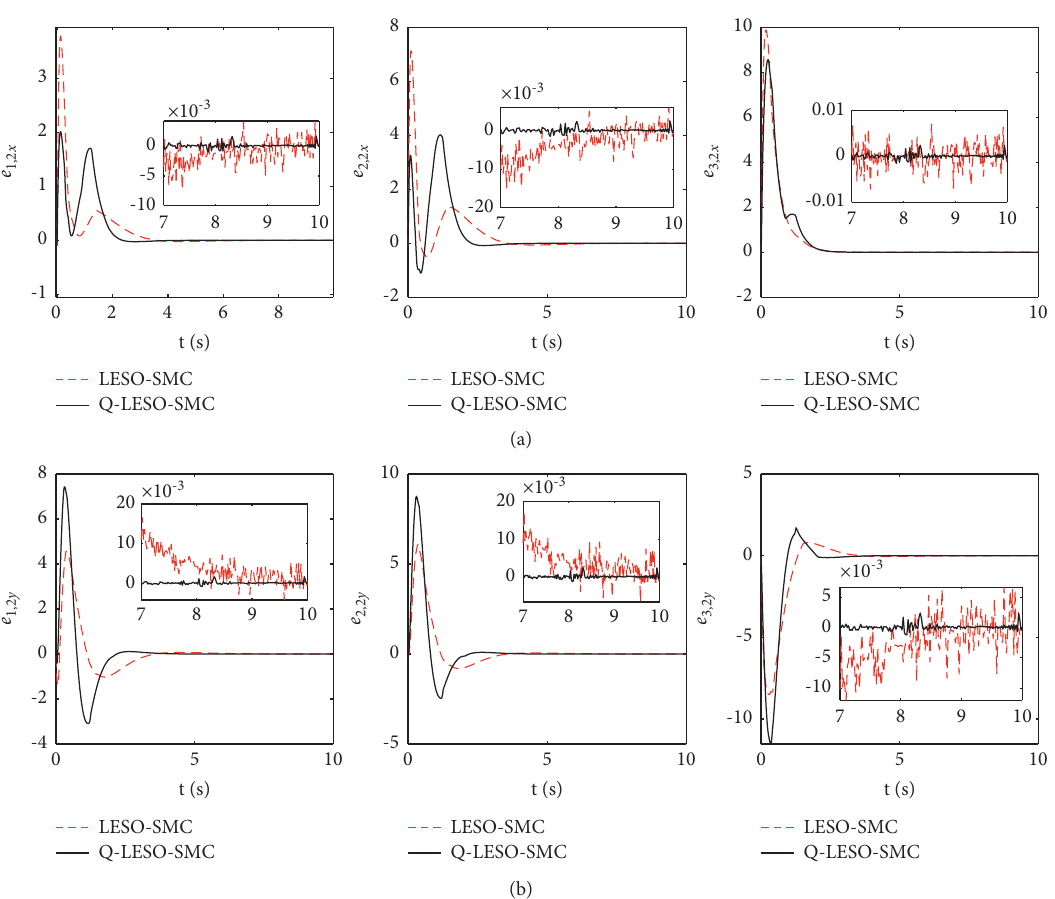
Figure 8: The formation tracking velocity error e i, 2 in Case A. (a) The formation tracking velocity error of the x -direction of the i th agent i � 1, 2, 3. (b) The formation tracking velocity error of the y -direction of the i th agent i � 1, 2,